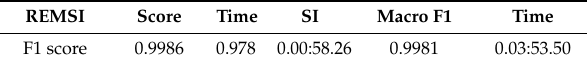
Table 9. Script identification